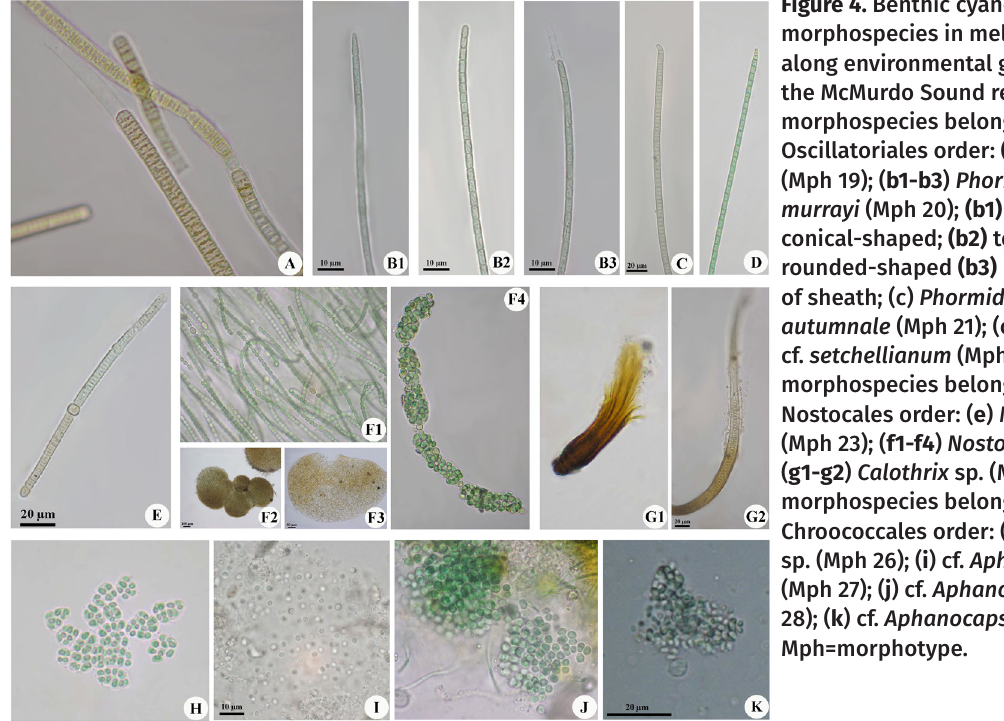
Figure 4. Benthic cyanobacterial morphospecies in meltwater ponds along environmental gradients in the McMurdo Sound region. (a-d) morphospecies belonging to